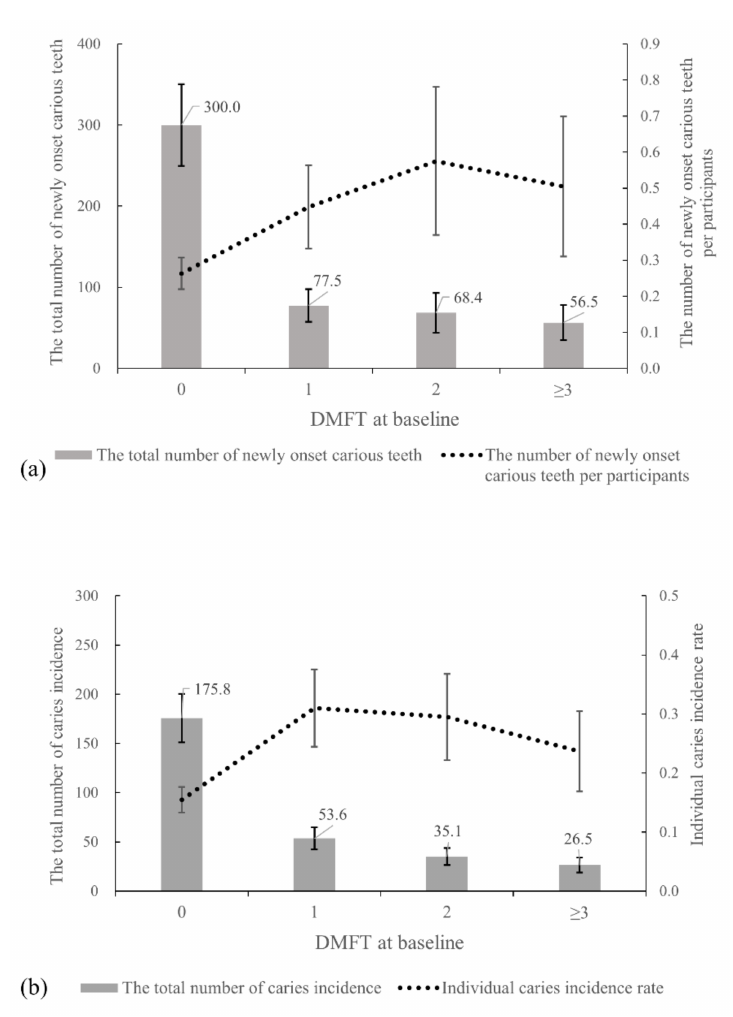
Figure 3. ( a ) The number of newly onset carious teeth per participant and the total number of carious teeth by DMFT at baseline. As DMFT at baseline rises, the number of newly onset carious teeth increases. However, the total number of newly onset caries is highest in the caries-free population (DMFT = 0) at baseline. ( b ) Individual caries incidence and the total number of students experiencing caries incidence by DMFT at baseline. Similar to the number of newly onset carious teeth, when DMFT ≥ 1 at baseline, the individual caries incidence rate is higher than DMFT = 0. However, the total number of individual caries incidence is highest in caries-free (DMFT = 0) at